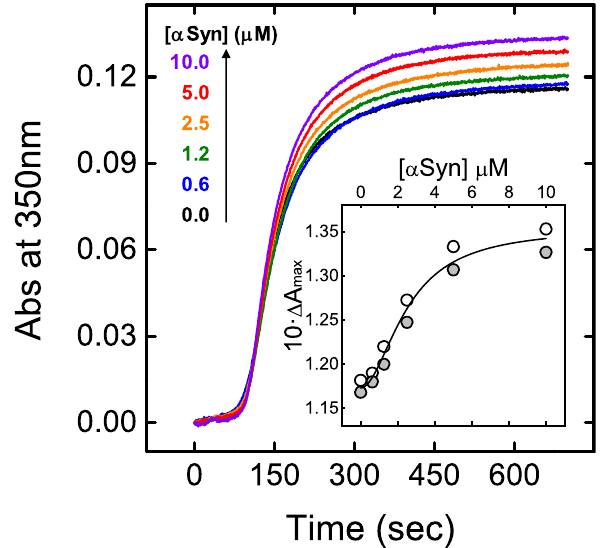
Figure 5. Effect of αSyn on αT-mediated fibrin generation. Representative turbidimetric analysis of fibrin generation induced by αT cleavage of purified fibrinogen at increasing αSyn concentrations, as indicated. To a desalted fibrinogen solution (440 nM, 800 μl) in HBS at 37 °C, containing 0.1% PEG-8000, was added αT (1 nM, final concentration) pre-incubated with increasing [αSyn] and the time-course of fibrin generation was monitored by recording the absorbance increase of the solution at 350 nm. From each clotting curve, the values of t c , and ΔA max were extracted. (Inset) Plot of ΔA max vs. αSyn concentration. Turbidimetric analysis was conducted in two independent measurements (n = 2), where each measurement was conducted as a technical duplicate. Each data point ( ○ , ) represents the average of the corresponding technical